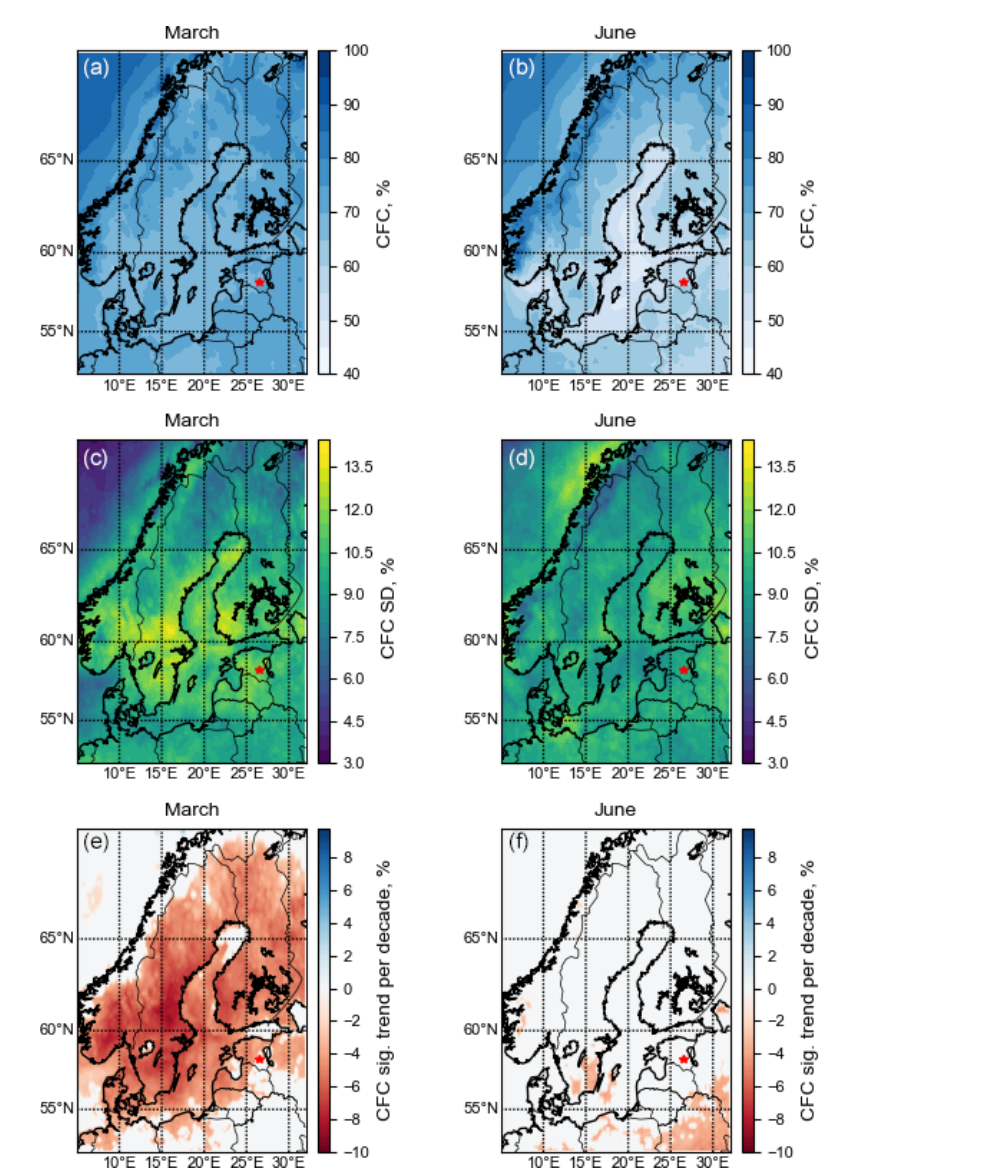
Figure 1. Monthly mean CFC 1982–2015 (a, b) , standard deviation of CFC 1982–2015 (c, d) and its significant trends from 1982 to 2015 (e, f) for March (a, c, e) and June (b, d, f) . Based on CLARA-A2 climate data record. The location of Tõravere station is marked with a red